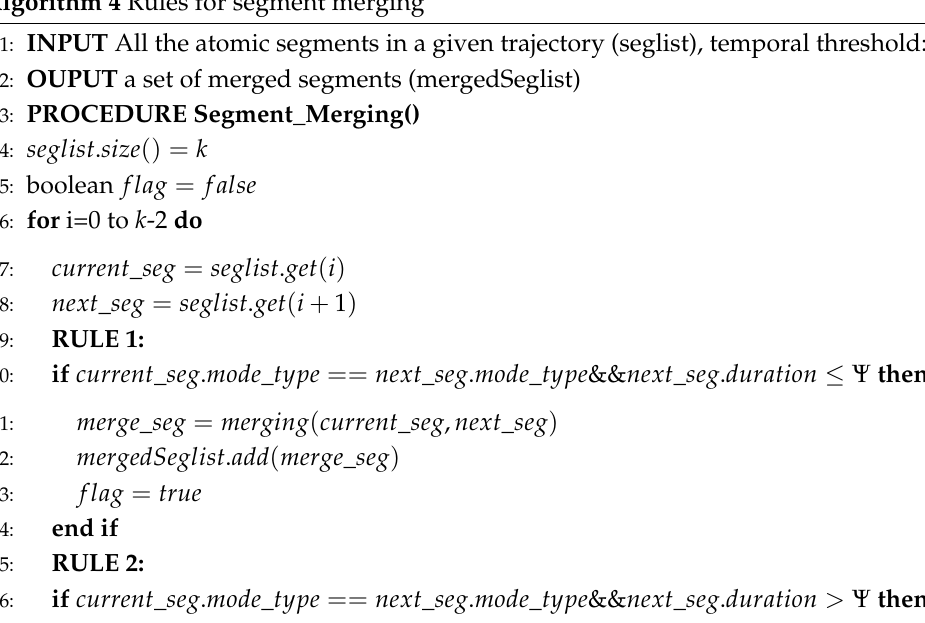
Algorithm 4 Rules for segment